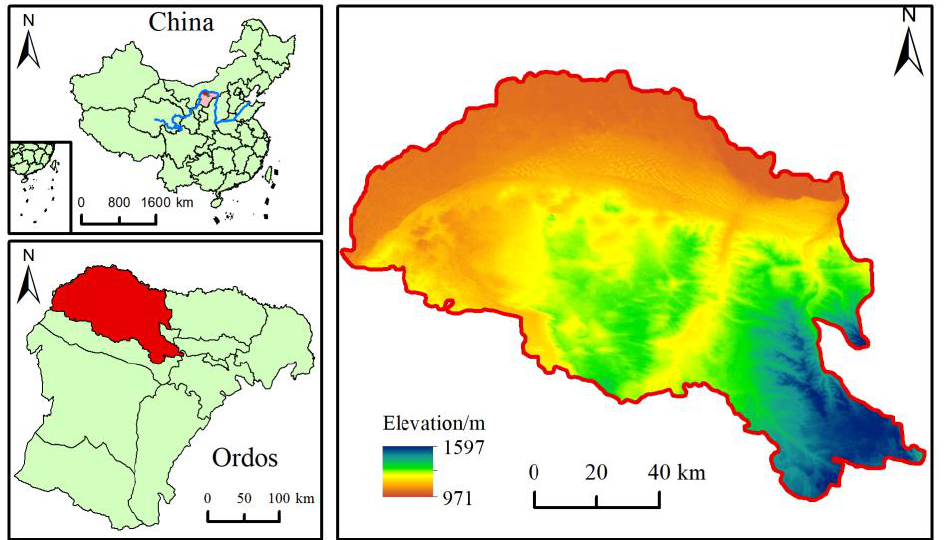
Figure 1. Location along the Yellow River section of the Hobq Desert.